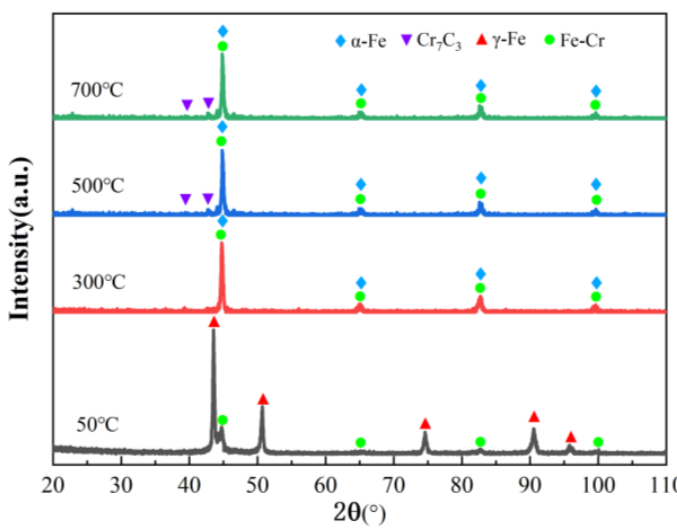
Figure 3. XRD spectrum of the FeCrSiNiCoC coating at different temperatures.